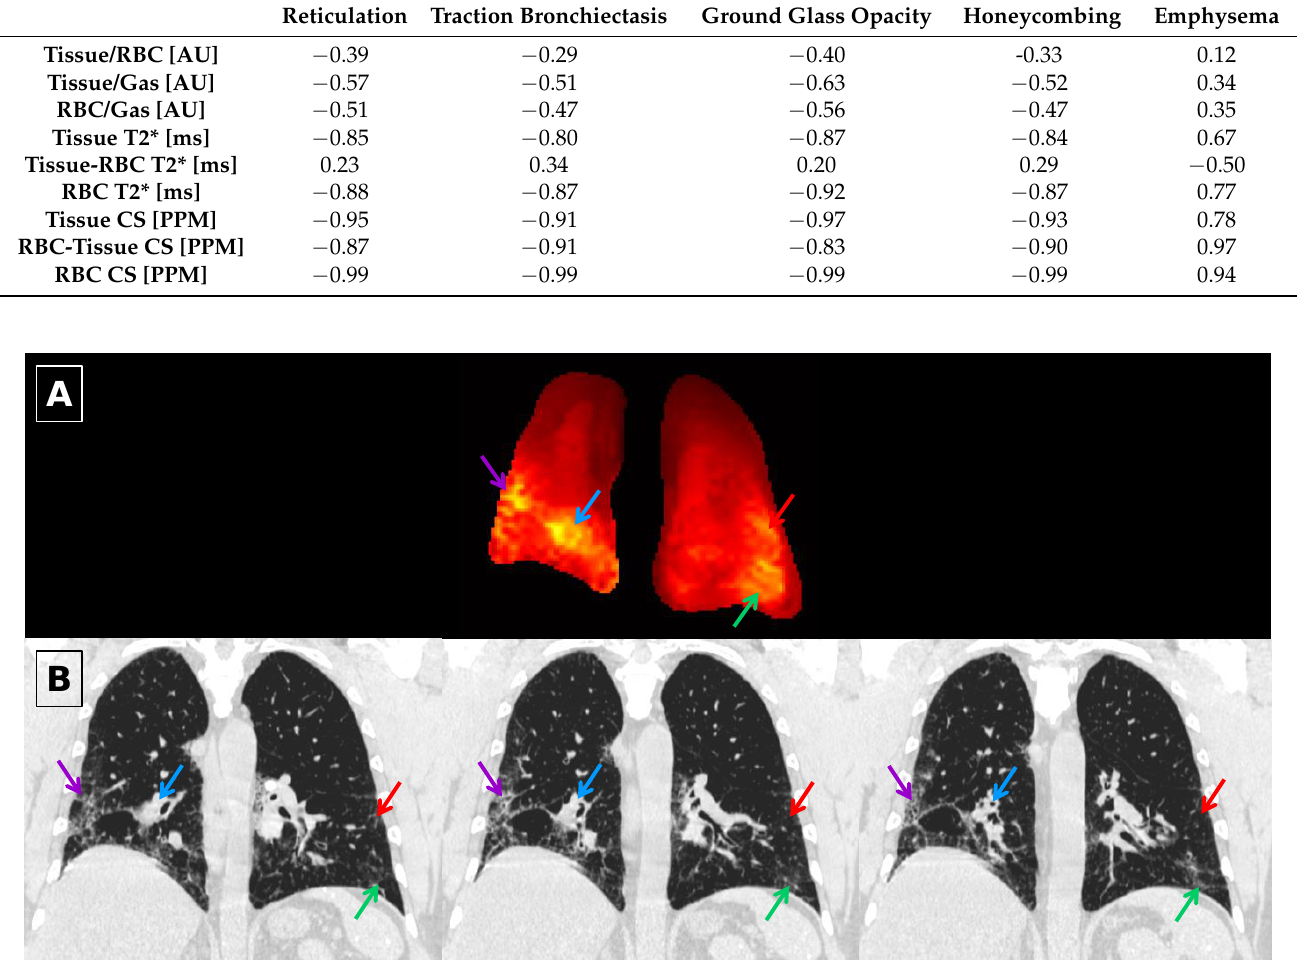
Table 5. Correlation Coefficients (R) between HRCT scores and 3D SBCSI data by lung region (Tables 3 and 4).